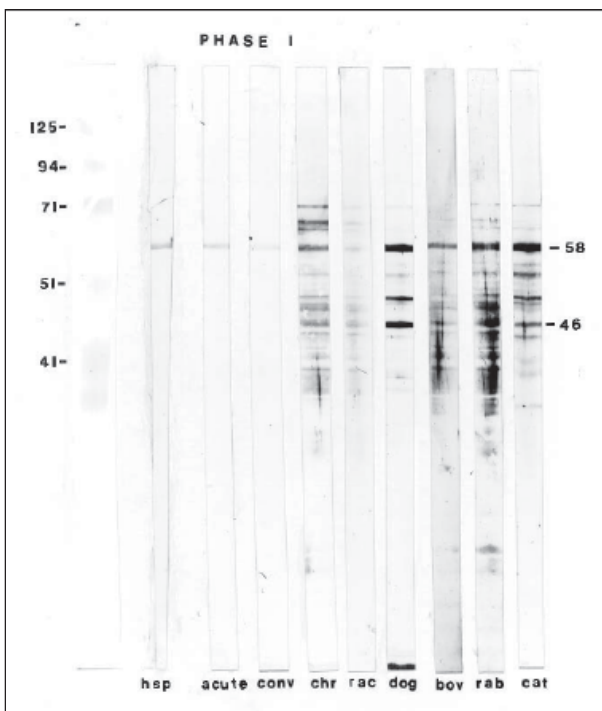
Figure 1) Western immunoblots showing immunoglobulin G antibod- ies directed against various antigens of phase I Coxiella burnetii